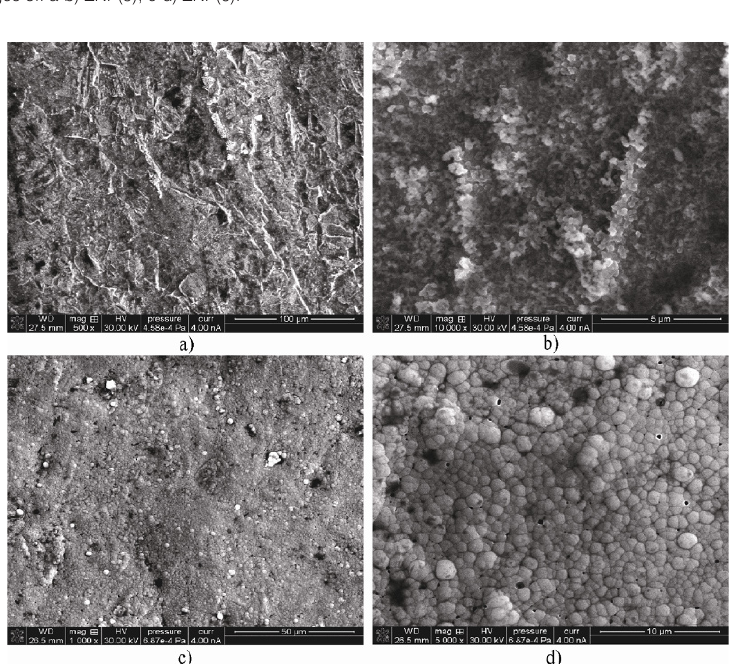
Figure 8. SEM images of: a-b) ZNP(7); c-d)